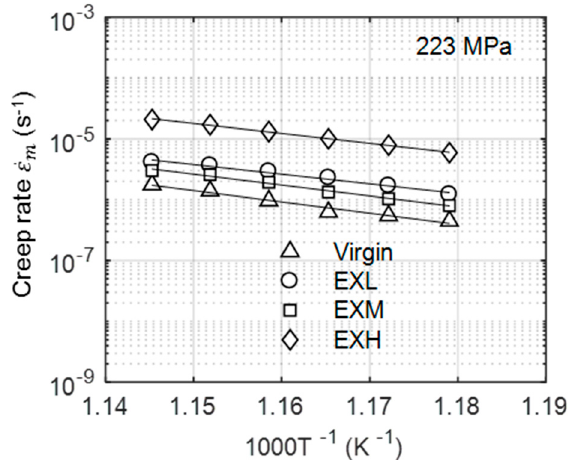
Figure 18. Logarithmic creep rate versus inverse temperature plots for all material states at 223 MPa.